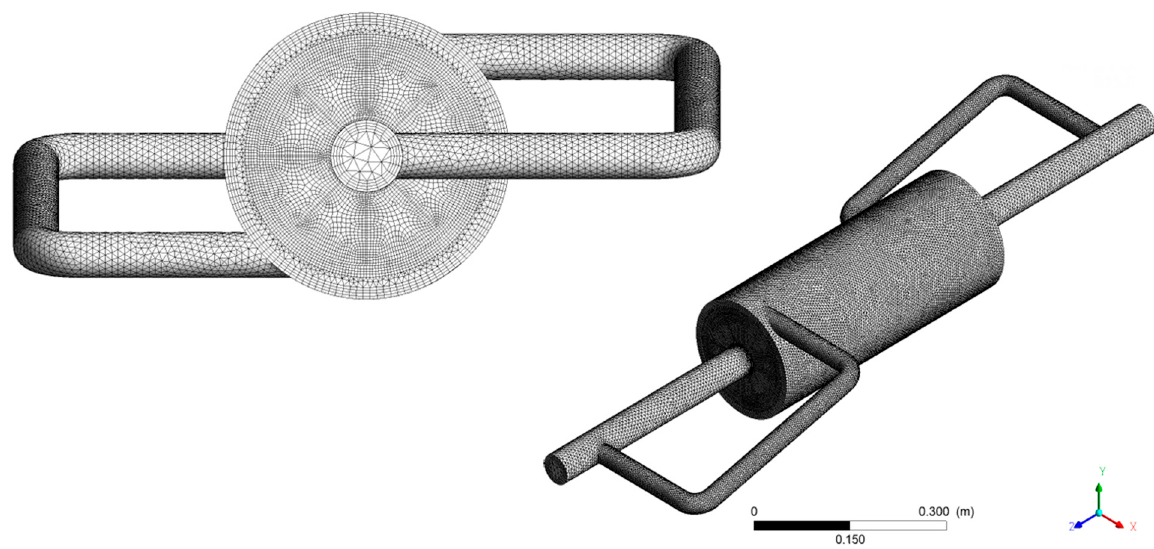
Figure 6. Isometric and front view of the TTHX representative mesh.